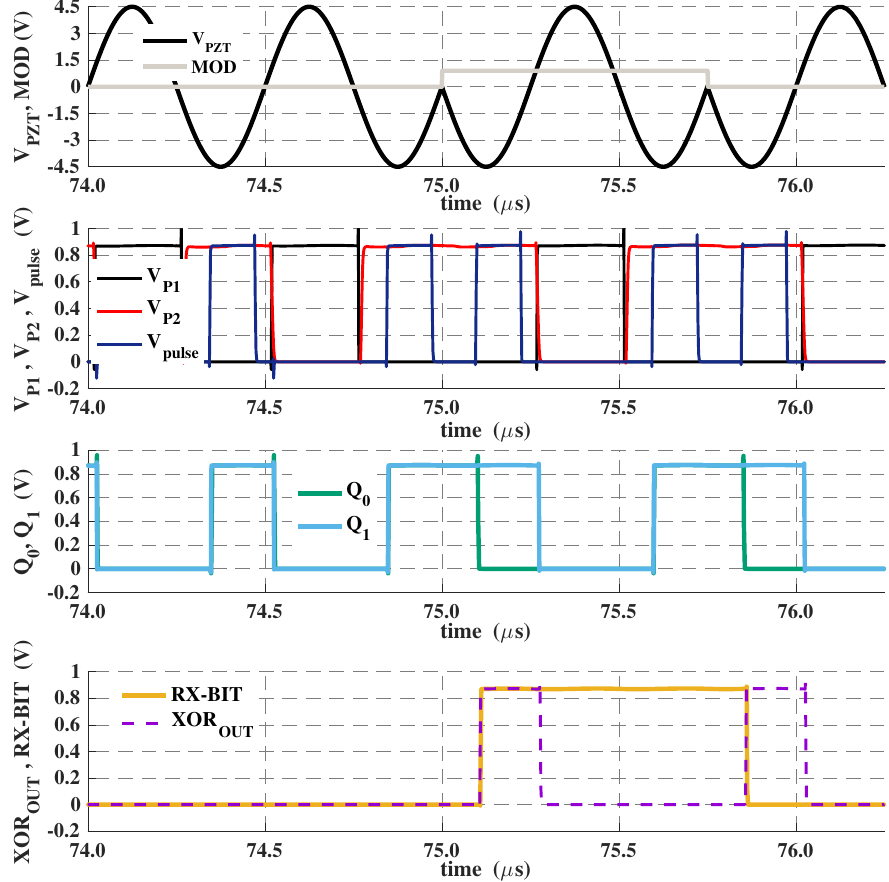
Figure 13. Timing-Diagram of the simulatedFully Digital BPSK